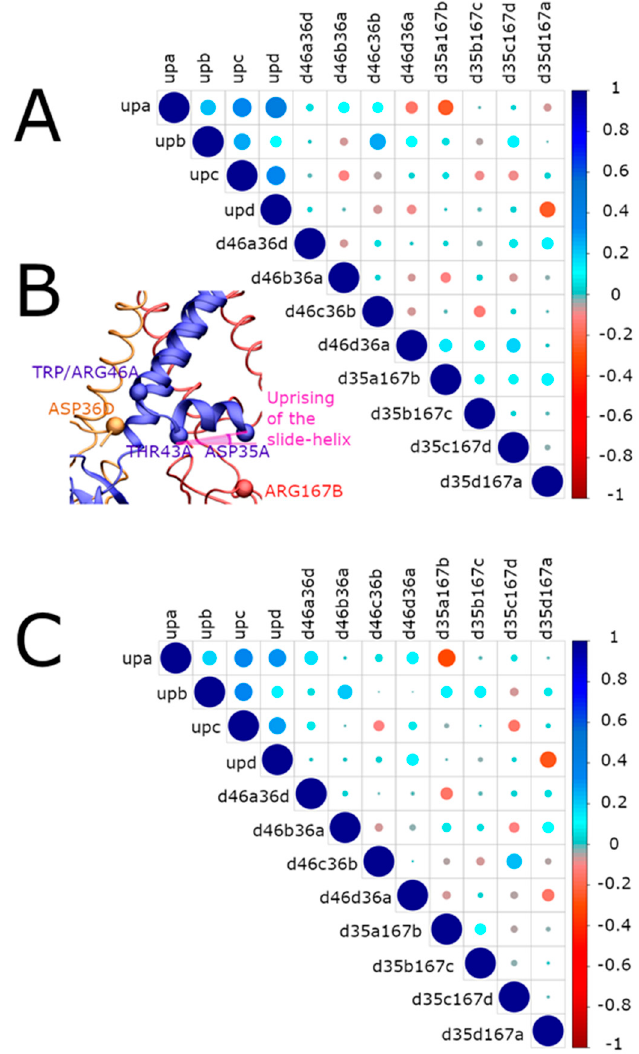
Figure 5. Correlation between the interactions of the slide helices and their upward movement in KirBac3.1 W46R and WT. ( A ) Correlations in the W46R mutant. The upward movement of the slide helix for the chains A, B, C, and D is denoted upx, where x is the letter of the chain. D46n36n-1 corresponds to the shortest distance between the R46 residue of the chain n and the D36 residue of the chain n − 1, and d35n167 n + 1 to that between the D35 residue of the chain n and the R167 residue of the chain n + 1. The blue circles correspond to positive correlations, while the red ones correspond to negative correlations. The diameter and the color intensity of a circle are proportional to the strength of the correlation. ( B ) Locations of the residues and the slide helix upward movement angle definition are considered in the correlations in pink. ( C ) Correlations in the case of KirBac3.1 WT. More precisely, (i) the shortest distance d46a36d, d46b36a, and d46c36b (see Figure 6’s caption for definitions) are correlated with the upward movement of the chain A ( upa ); (ii) distances d46c36b, and d46d36c are correlated with the upward movement of the chain B ( upb ); (iii) the distances d46d36c, and d46a36b, are correlated with the upward movement of